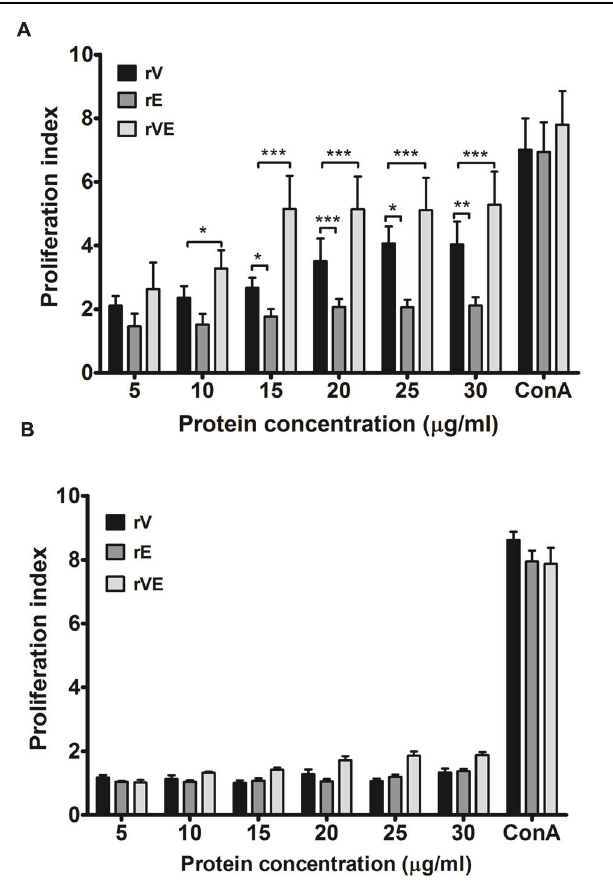
FIGURE 3 | Proliferation assay performed with lymphocytes isolated from the spleen of immunized and sham immunized groups of mice at 43rd day. (A) Lymphocytes isolated from the rV, rE, and rVE immunized mice were cultured in 96-well flat bottom plates with a gradient concentration of purified recombinant proteins. After 72 h of incubation at 37 ◦ C (5% CO 2 ), proliferative responses were determined by MTT assay. (B) Proliferation assay performed with lymphocytes obtained from sham immunized mice spleen and were stimulated with gradient concentration of purified recombinant proteins (rV, rE, and rVE). The T-cell inducer, ConA at 20 μ g/ml was considered as positive control. Extracted lymphocytes with culture medium alone were used as a negative control. Data represented as PI mean values ± SD. ∗ P < 0.05; ∗∗ , P < 0.01; ∗∗∗ , P < 0.001; compared to control group (sham immunized